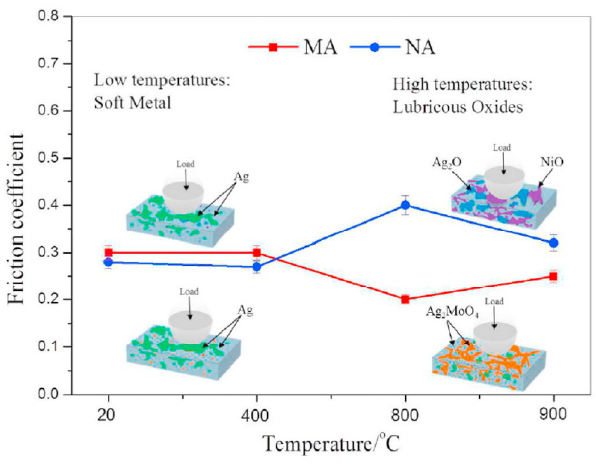
Fig. 47 Illustration of the lubrication mechanism of Ni 3 Al–Ag alloy (NA) and Ni 3 Al–Ag alloy containing Cr, Mo, Zr, B (MA) [813]. Reproduced with permission from Ref. [813], © Elsevier B.V.,